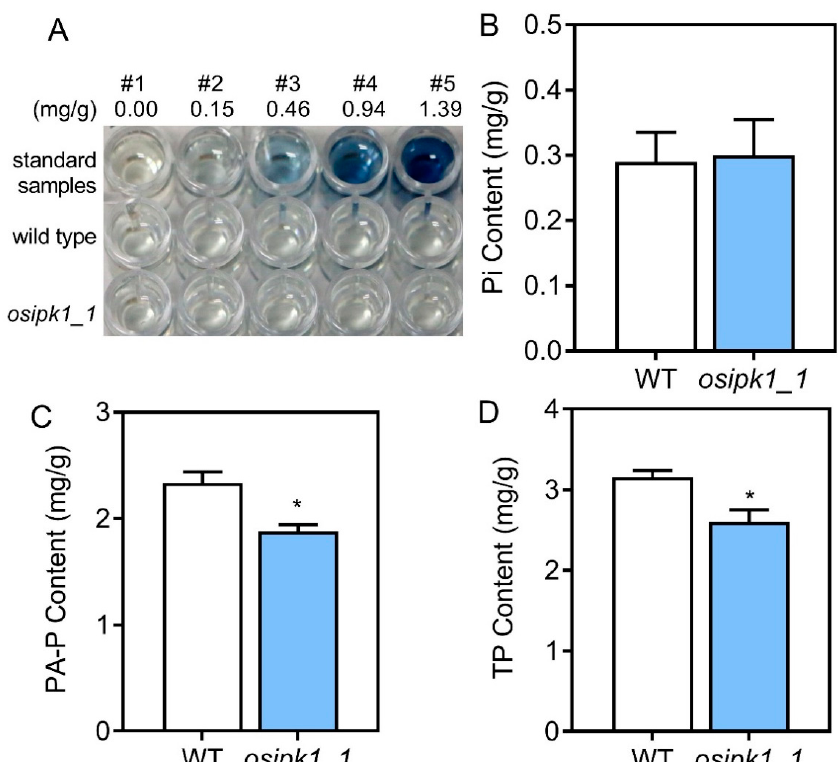
Figure 3. Inorganic P (Pi), phytic acid P (PA-P), and total phosphorus (TP) contents in Xidao #1 (WT) and its OsIPK1 mutant line osipk1_1 . ( A ) Qualitative assay of inorganic phosphorus (Pi) in mutant seeds. The concentration of the Pi standard samples were shown above. Five replicates were performed for WT and osipk1 _1. ( B – D ) Three replicates were performed for WT and osipk1 _1. Error bars represent standard error. Data with an asterisk(s) are significantly different from WT (* p < 0.05).